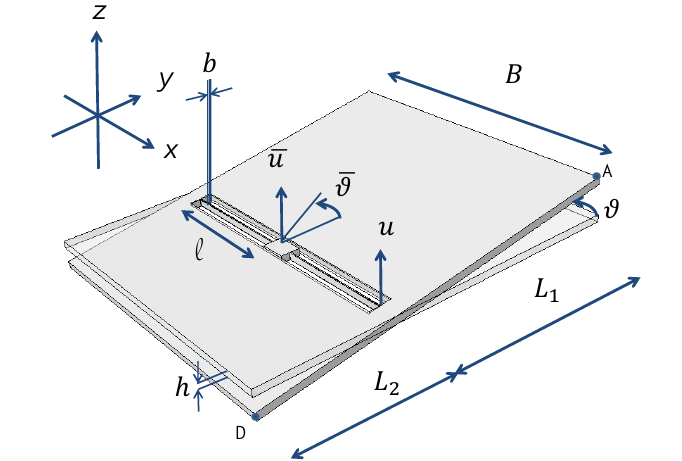
Figure 1. Geometry of the uni-axial MEMS accelerometer, and